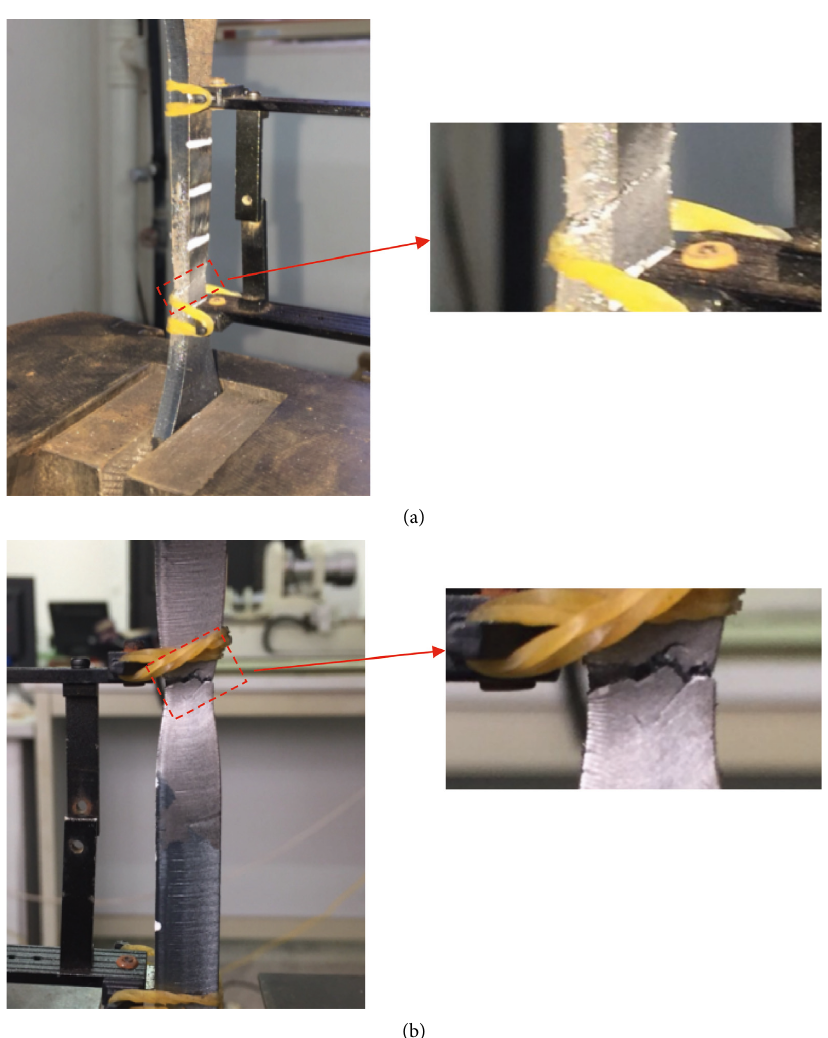
Figure 4: (a) Failure mode II of specimens with welded joint. (b) Failure mode III of specimens with welded